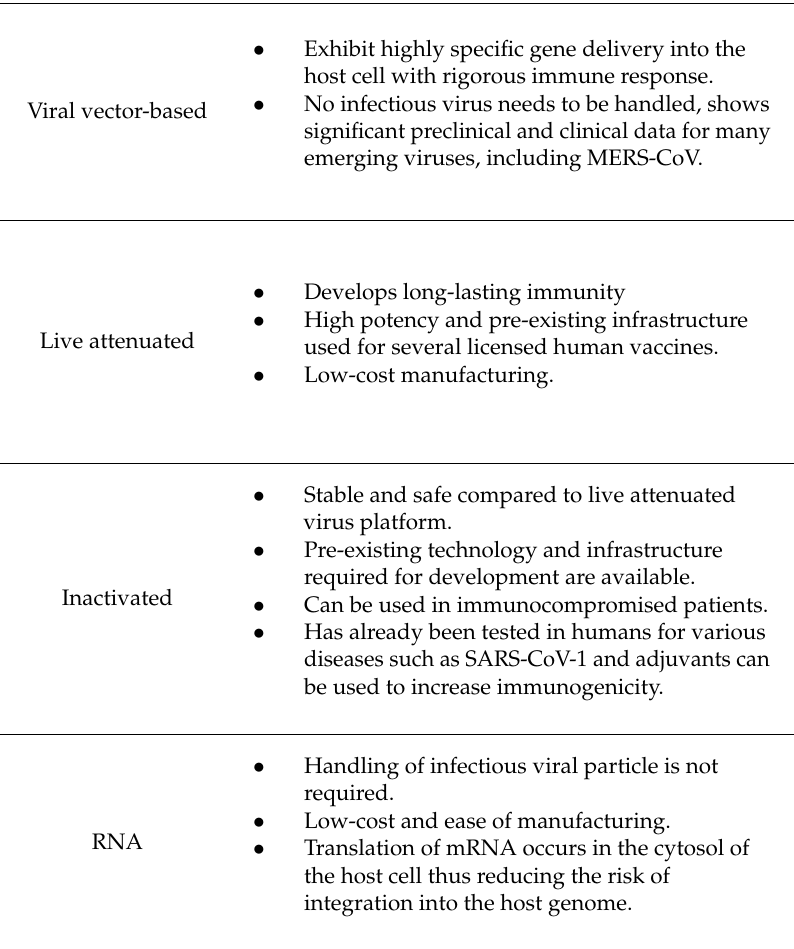
Table 2. Different vaccine platforms—pros and cons and examples of licensed non-SARS-CoV-2 vaccines for humans. Vaccine